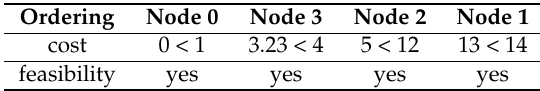
Table 4. A feasible solution for the network G 1